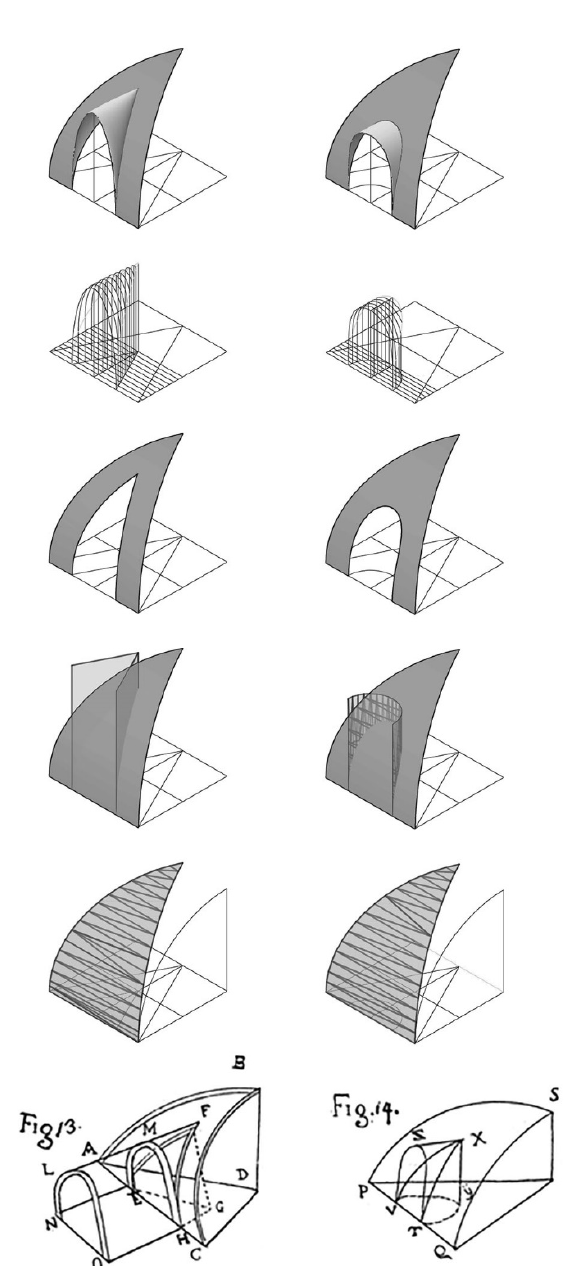
Figure 1. Lunette vaults in Plate XIX of Architettura Civile (Modelling: R. Spallone)